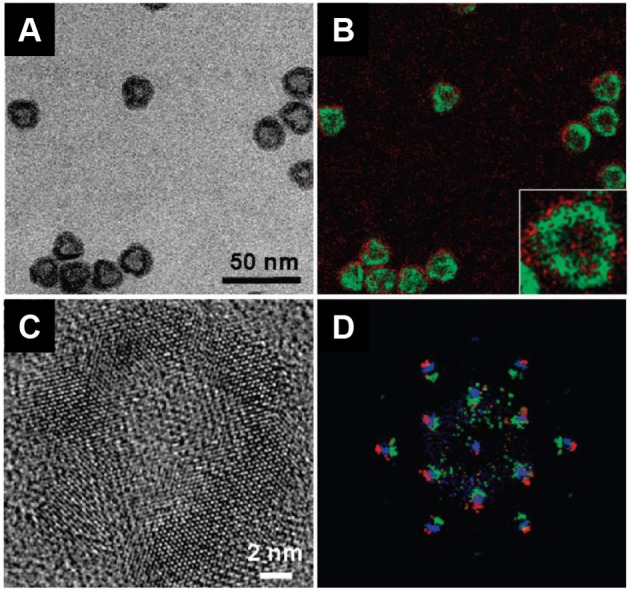
TEM (A), EFTEM (B), and HRTEM (C) of annealed core-shell nanoparticles. EFTEM strongly suggest the formation of a ZnO1−xSx nanoalloy. (D) FFT image of (C) overlaid on FFT image of the precursor ZnO@ZnS core-shell nanoparticles (red: ZnO; green: ZnS; blue: annealed nanoparticles). These images support the heteroepitaxial formation of the ZnS shell and ZnO1−xSx when thermally annealed. Adapted with permission from Park et al. (2009), copyright (2006) American Chemical Society.